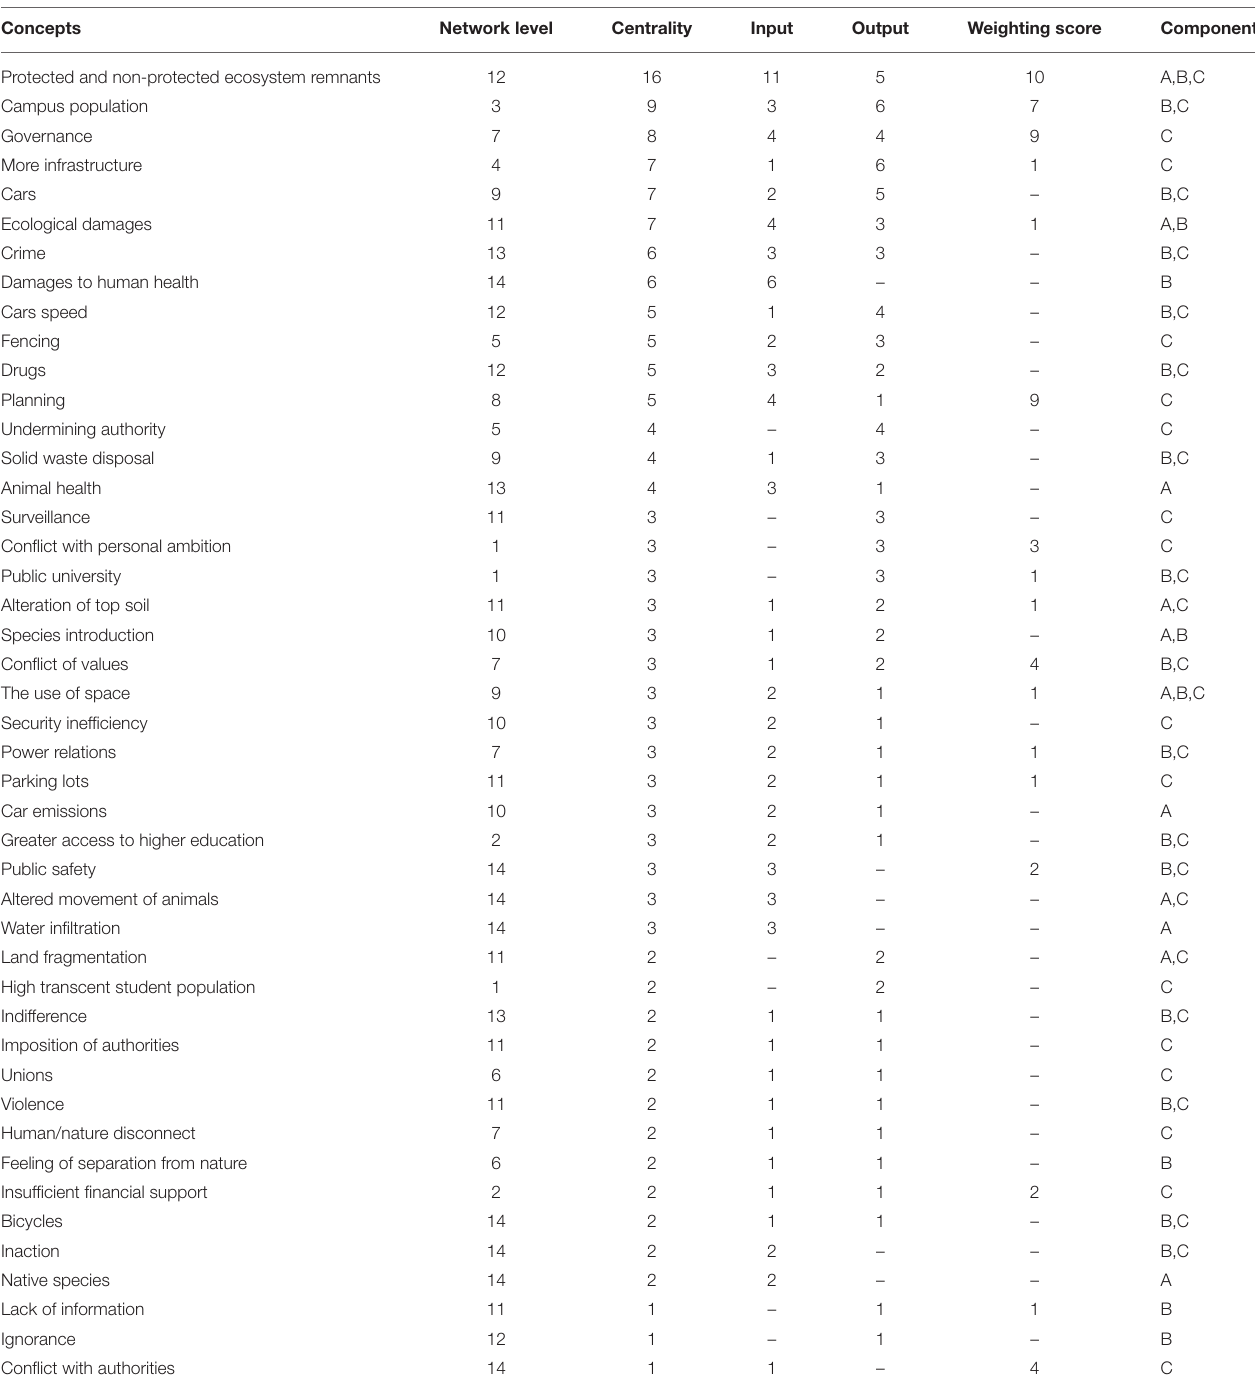
TABLE 2 | Concepts location and